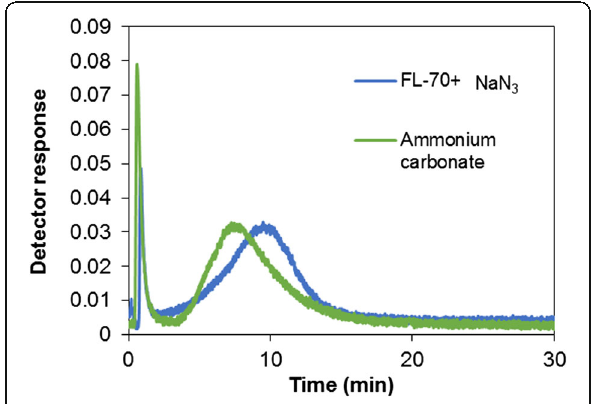
Fig. 3 Comparison of elution profiles of 100 nm silica nanoparticles with 0.02% FL-70 with 0.02% NaN 3 (blue) and 0.25 mM ammonium carbonate (green) as carrier solutions, with the use of membrane RC 1